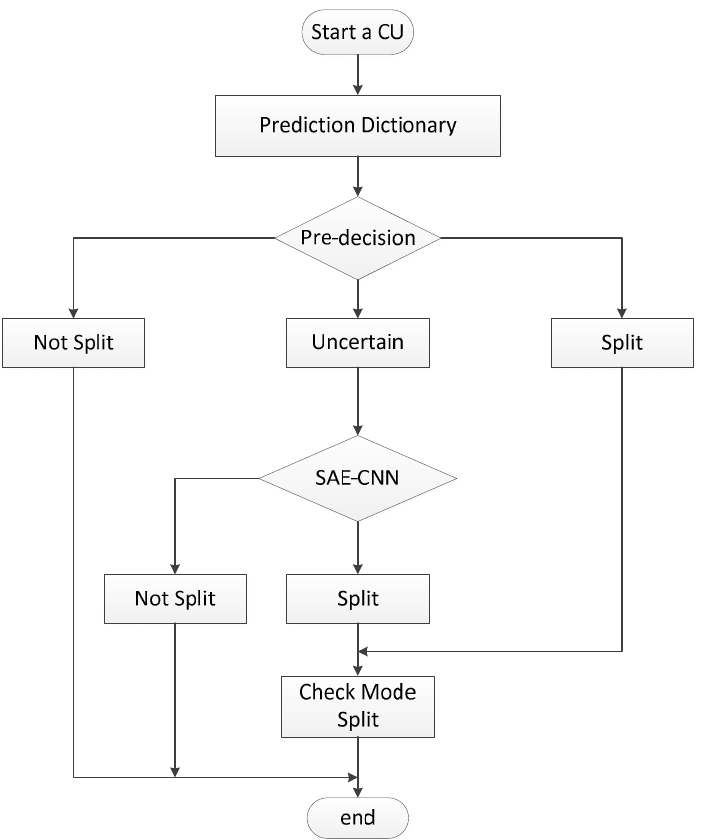
Figure 3. Flow chart of self-adaptive CU size partition decision.